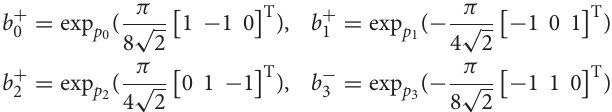
algorithm from Algorithm 1 employs the Armijo rule